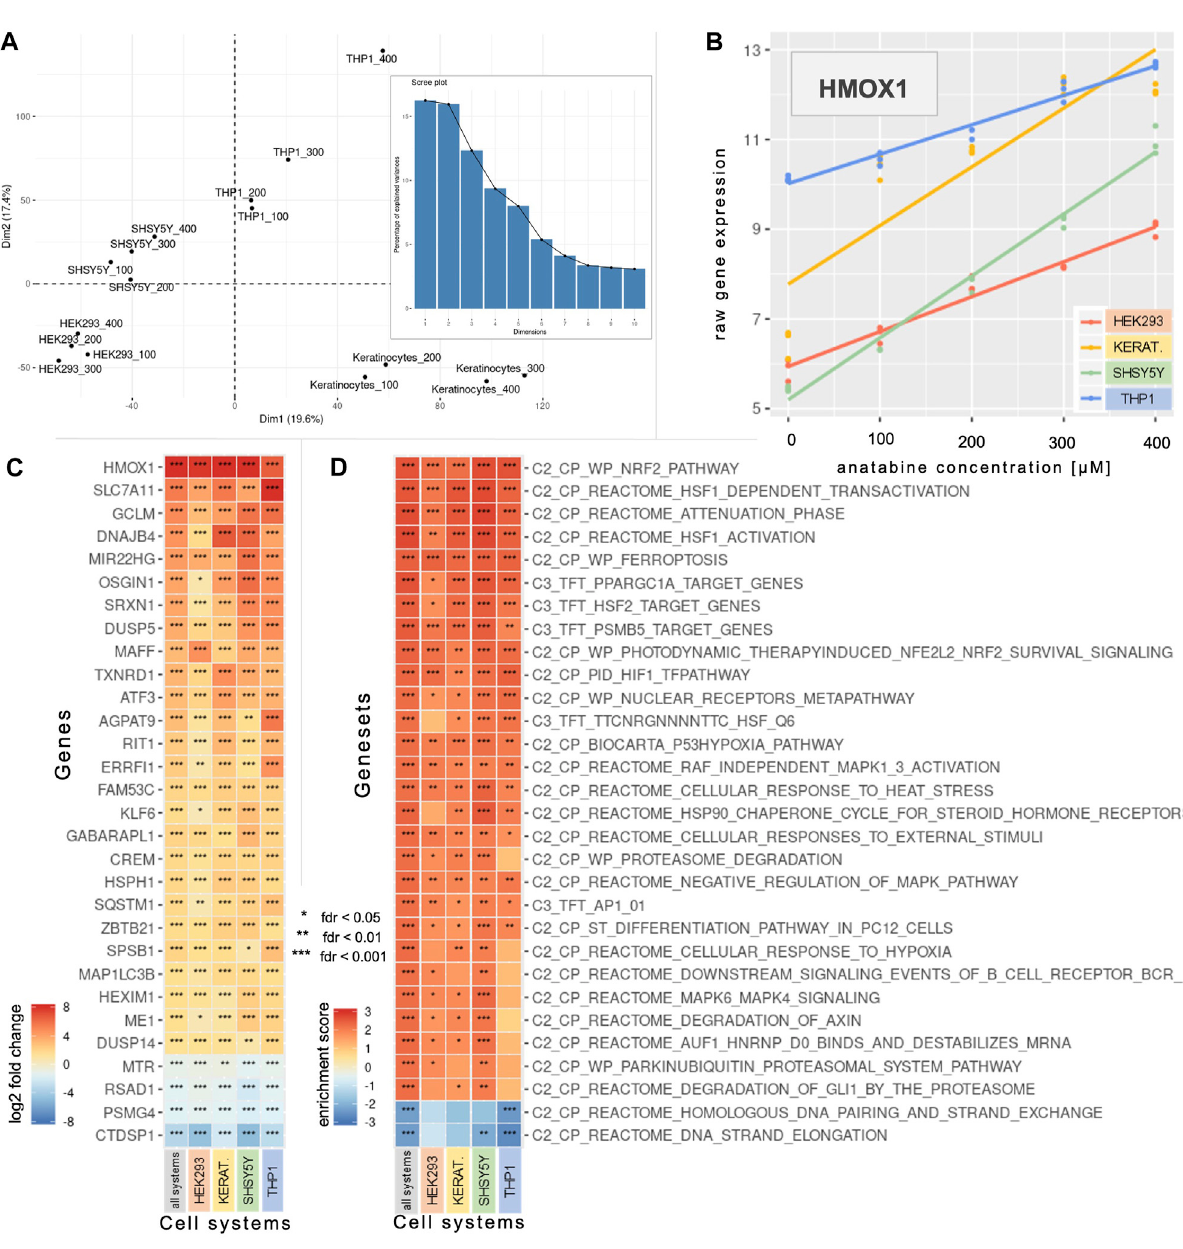
changes in the expression of the gene heme oxygenase 1 ( HMOX1 ) for each of the tested cell systems. The slope of each depicted linear regression line portrays the modi fi cation